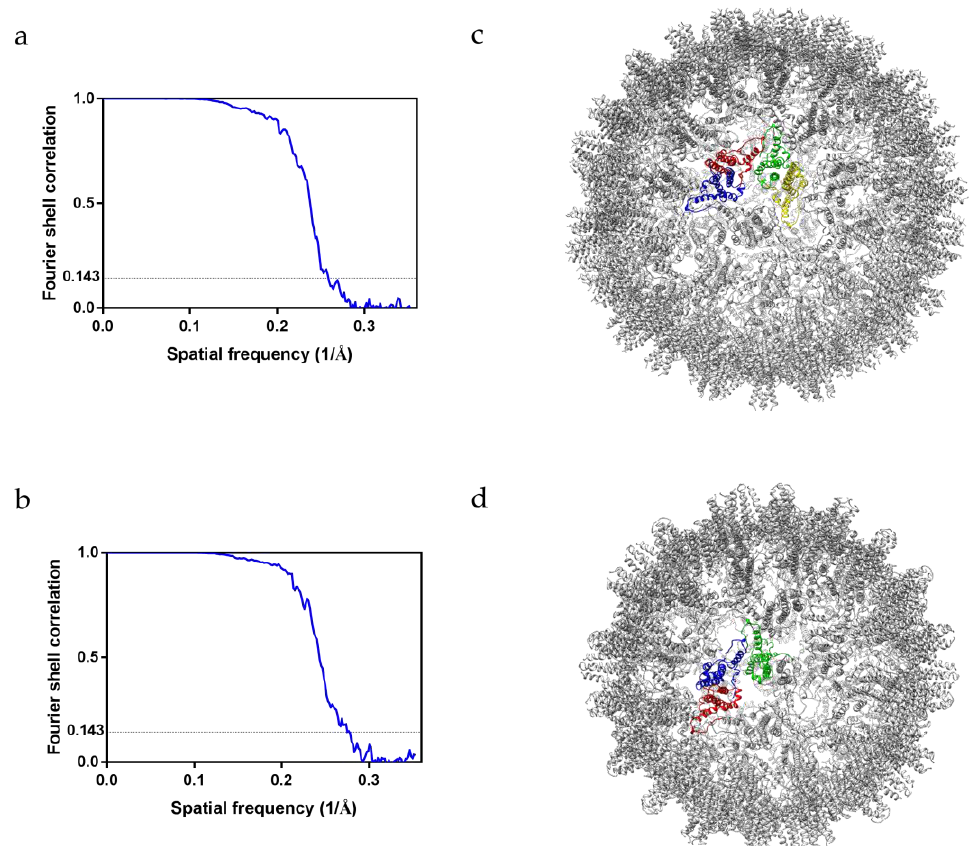
Figure 3. FSC curves and molecular structures of HAF. ( a ) FSC curve of HAF (T = 4 state) reconstruction. The dashed line indicates the correlation of 0.143 which was used as cutoff for determining the resolution. The final resolution is 3.86 Å. ( b ) FSC curve of HAF (T = 3 state) reconstruction. The dashed line indicates the correlation of 0.143 which was used as cutoff for determining the resolution. The final resolution is 3.60 Å. ( c ) The molecular structure of HAF (T = 4 state). The four subunits forming the asymmetric unit are colored in red, blue, green, and yellow. ( d ) The molecular structure of HAF (T = 3 state). The three subunits forming the asymmetric unit are colored in red, blue, and green.